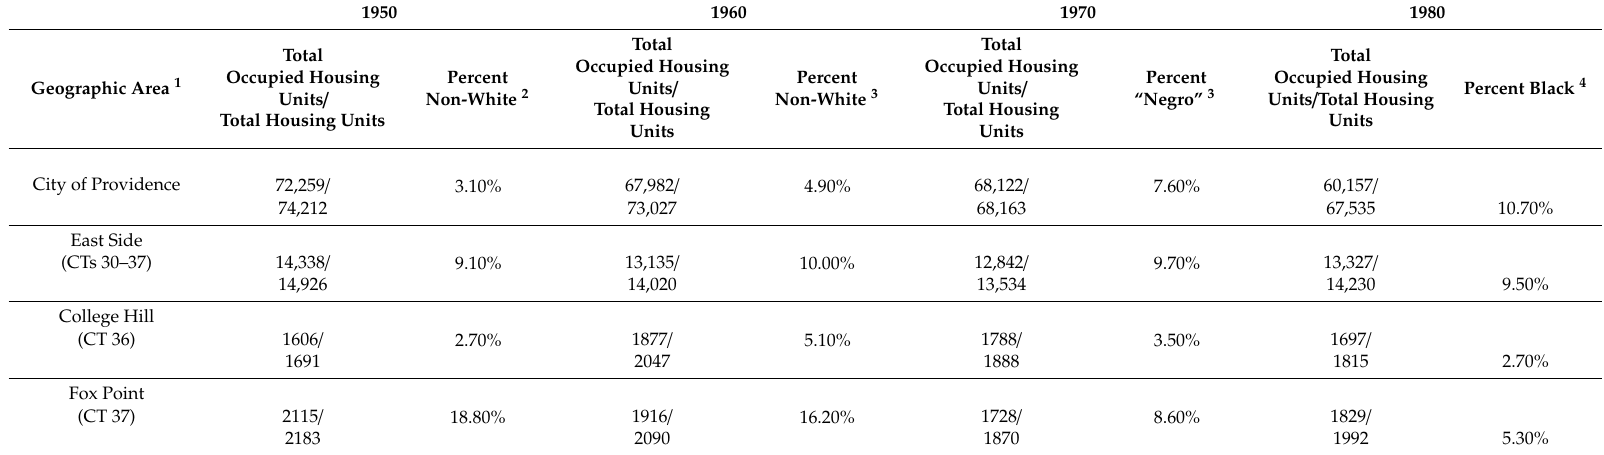
Table 1. Census racial classification of households 1950–1980 Providence RI and East Side